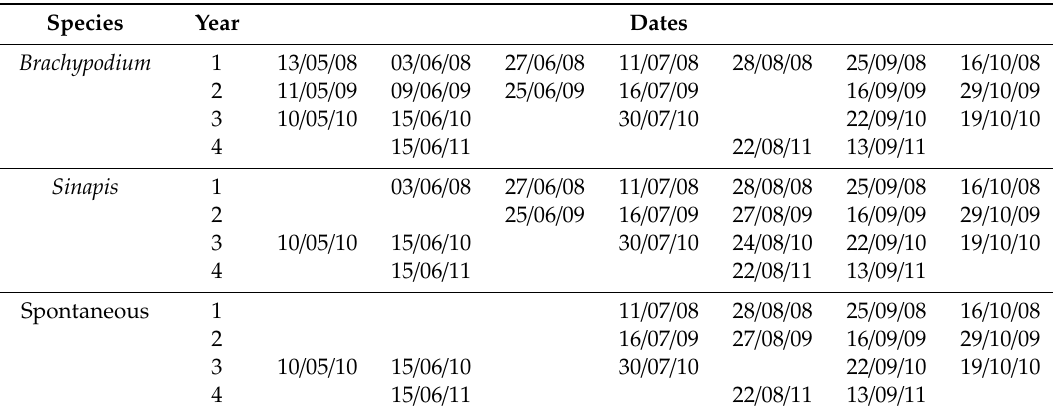
Table 3. Sampling dates in the studied cover